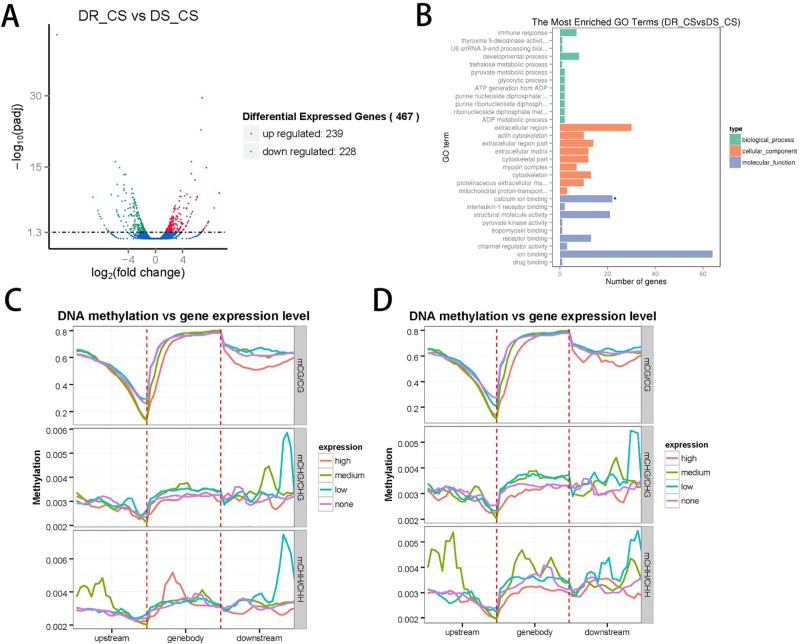
Integrated analysis of the genome-wide DNA methylation and gene expression profiles. (A) The number of differentially expressed genes (DEGs) identified by comparing DR-CS and DS-CS. The red dots represent the 239 upregulated genes in DR-CS compared with DS-CS. The green dots represent the 228 downregulated genes in DR-CS compared with DS-CS. (B) Gene ontology enrichment analysis of the downregulated DEGs. The GO enrichment analysis results for the differentially expressed genes are classified into the following three categories: biological process (green histogram), cellular component (orange histogram), and molecular function (blue histogram). The x axis is the corresponding number of genes, and the y axis is the gene ontology (GO) gene function classification. * indicates significant enrichment (P adjusted value < 0.05). (C) Methylation levels in CG, CHG, and CHH contexts of differentially expressed genes from DR-CS. The DEGs were divided into the following four groups according to their expression levels: none (FPKM <1), low (1 < FPKM < Q1), medium (Q1 < FPKM < Q3), high (FPKM > Q3). (D) Methylation levels in CG, CHG, and CHH contexts of differentially expressed genes from DS-CS. The DEGs were divided into the following four groups according to their expression level: none (FPKM < 1), low (1 < FPKM < Q1), medium (Q1 < FPKM < Q3), high (FPKM > Q3).